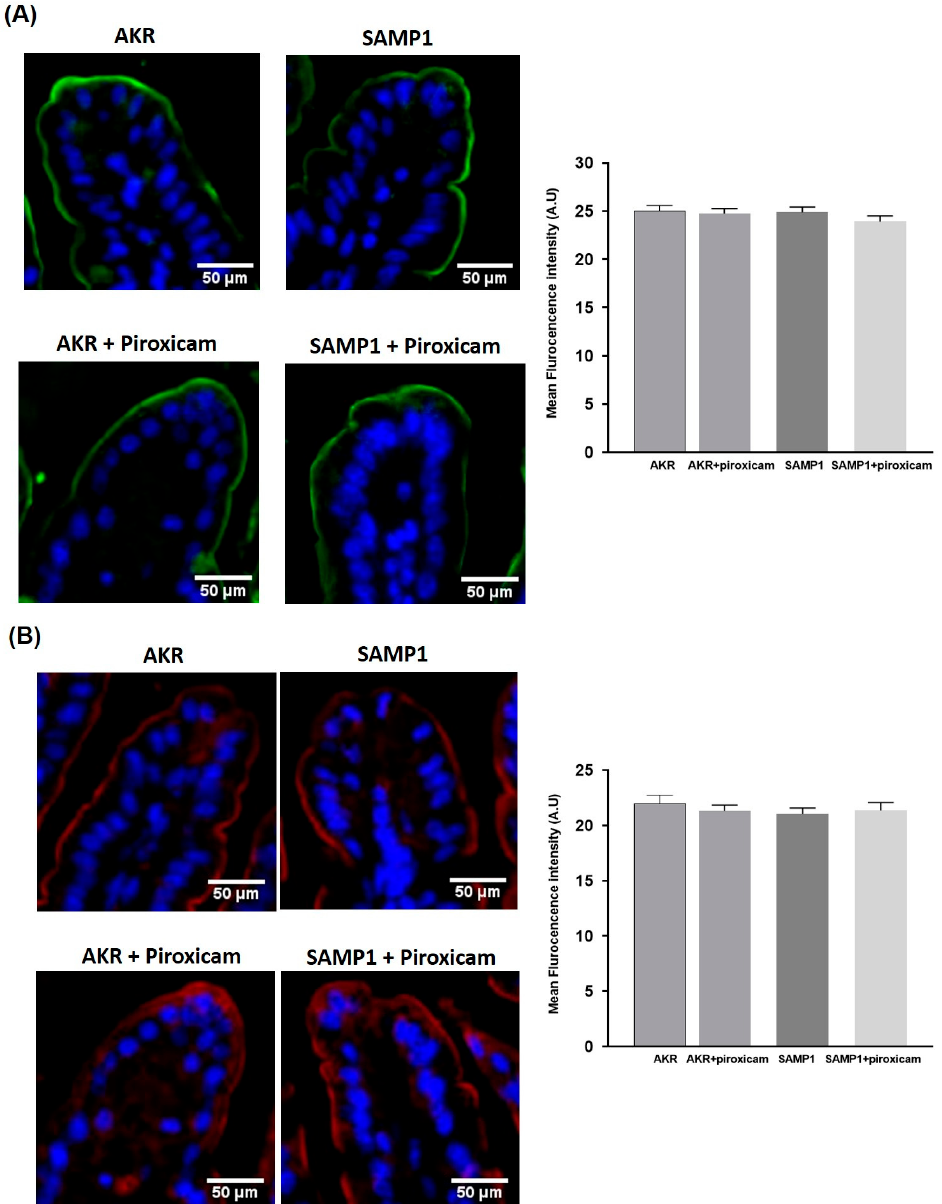
Figure 7. Immunofluorescence staining of DRA and PAT1 in small intestinal mucosa of SAMP1/AKR mice. ( A ) (Left panel): Immunofluorescence staining of small intestinal mucosal sections of AKR and SAMP1 mice for DRA (green) and DAPI (blue). Representative image of 4 independent experiments is shown. Images were captured at 20× magnification. (Right panel): Quantification of DRA immunostaining intensity by Image J software showed no alterations of DRA levels in AKR versus SAMP1 mice or in response to piroxicam treatments. ( B ) (Left panel): Immunofluorescence staining of small intestinal mucosal sections of AKR and SAMP1 mice for PAT1 (red) and DAPI (blue). Representative image of 4 independent experiments is shown. (Right panel): Quantification of DRA immunostaining intensity by Image J software showed no alterations of PAT1 protein levels in AKR versus SAMP1 mice or in response to piroxicam treatments.